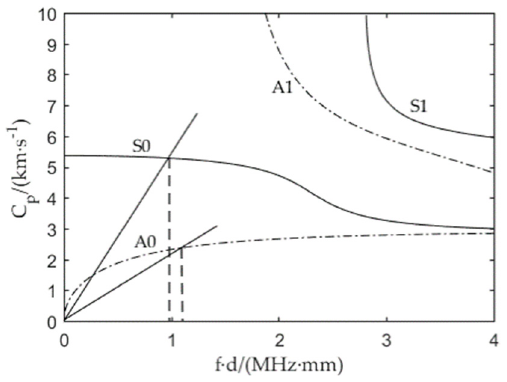
Figure 1. Schematic diagram of a meander-line coil electromagnetic acoustic transducer (EMAT).